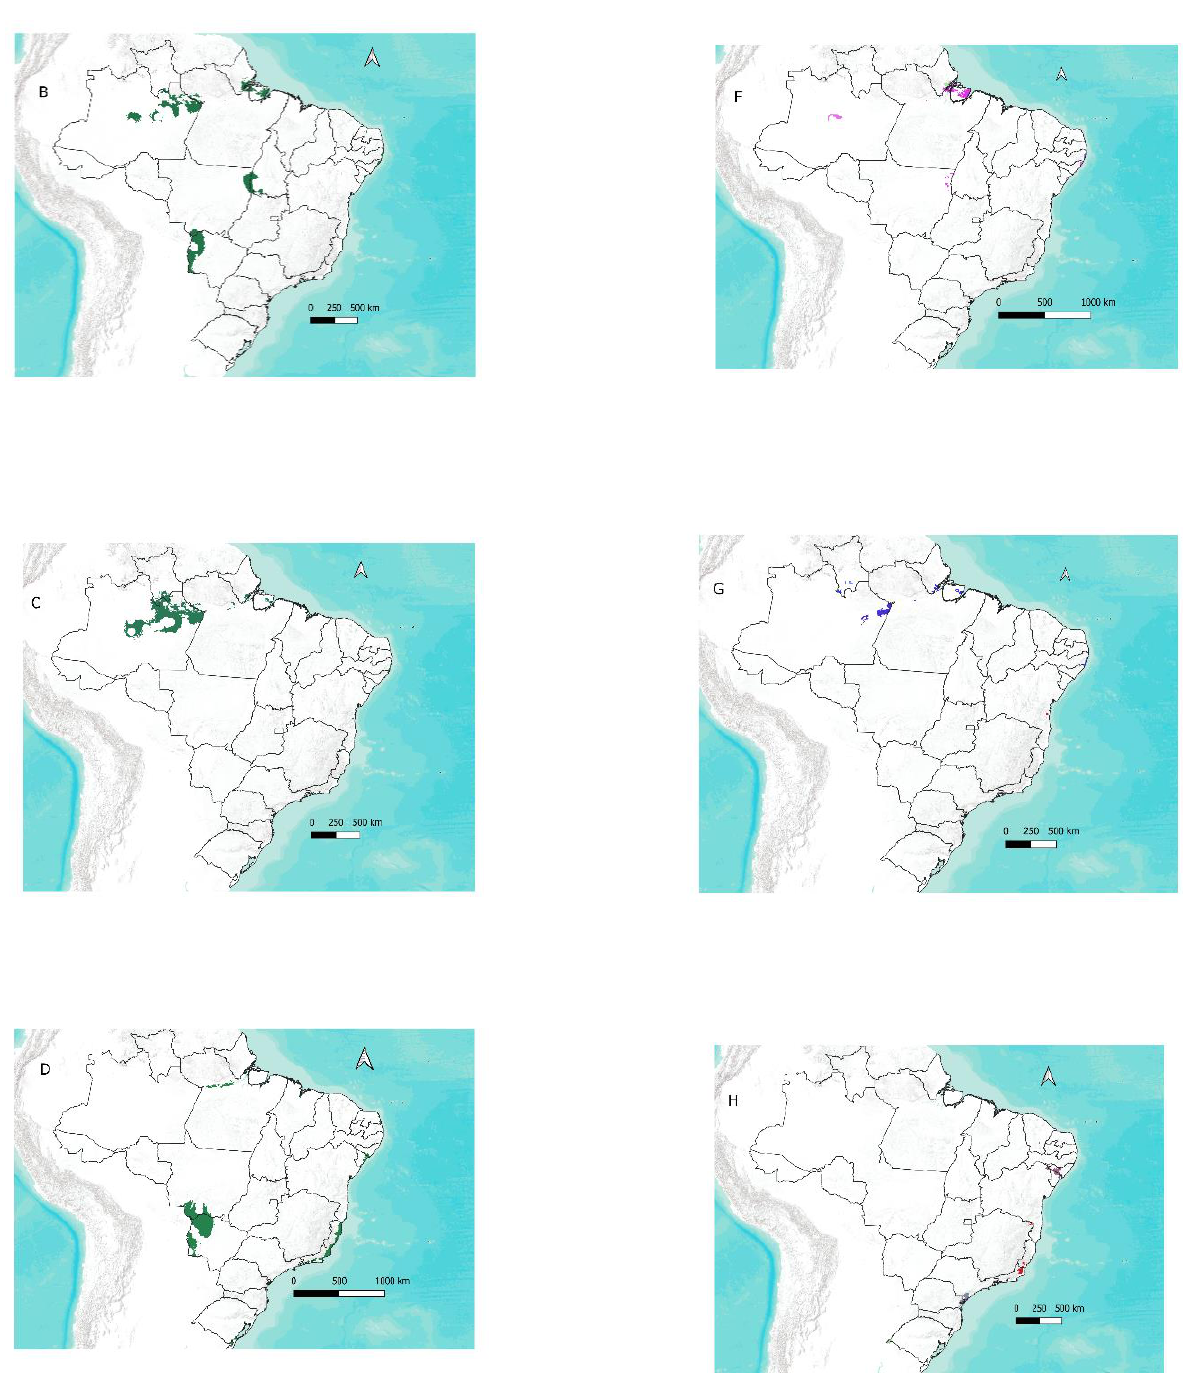
Figure 1. In green, areas of potential distribution not conserved ex situ for Oryza alta ( A ), O. glumaepatula ( B ), O. grandiglumis ( C ), and O. latifolia ( D ). In color, non-conserved ex situ ecoregions for Oryza alta ( E ), O. glumaepatula ( F ), O. grandiglumis ( G ), and O. latifolia ( H ).